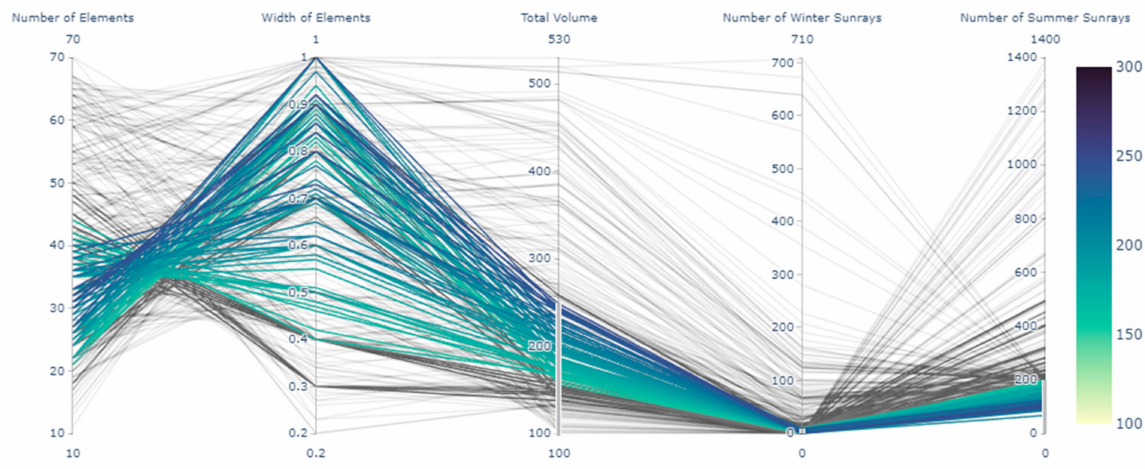
Figure 11. Parallel coordinates graph for filtering